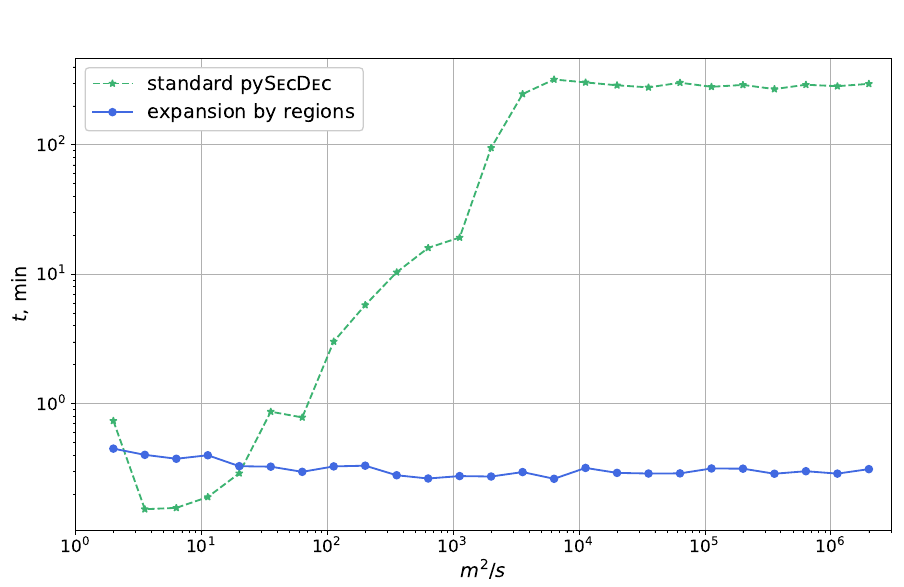
Figure 3: Scan over different orders of magnitude of r = m 2 / s for the two-loop triangle given in Fig 2. Integration times (in minutes) are plotted against r . The relative accuracy goal is 10 − 3 ; the wall clock limit has been set to 5